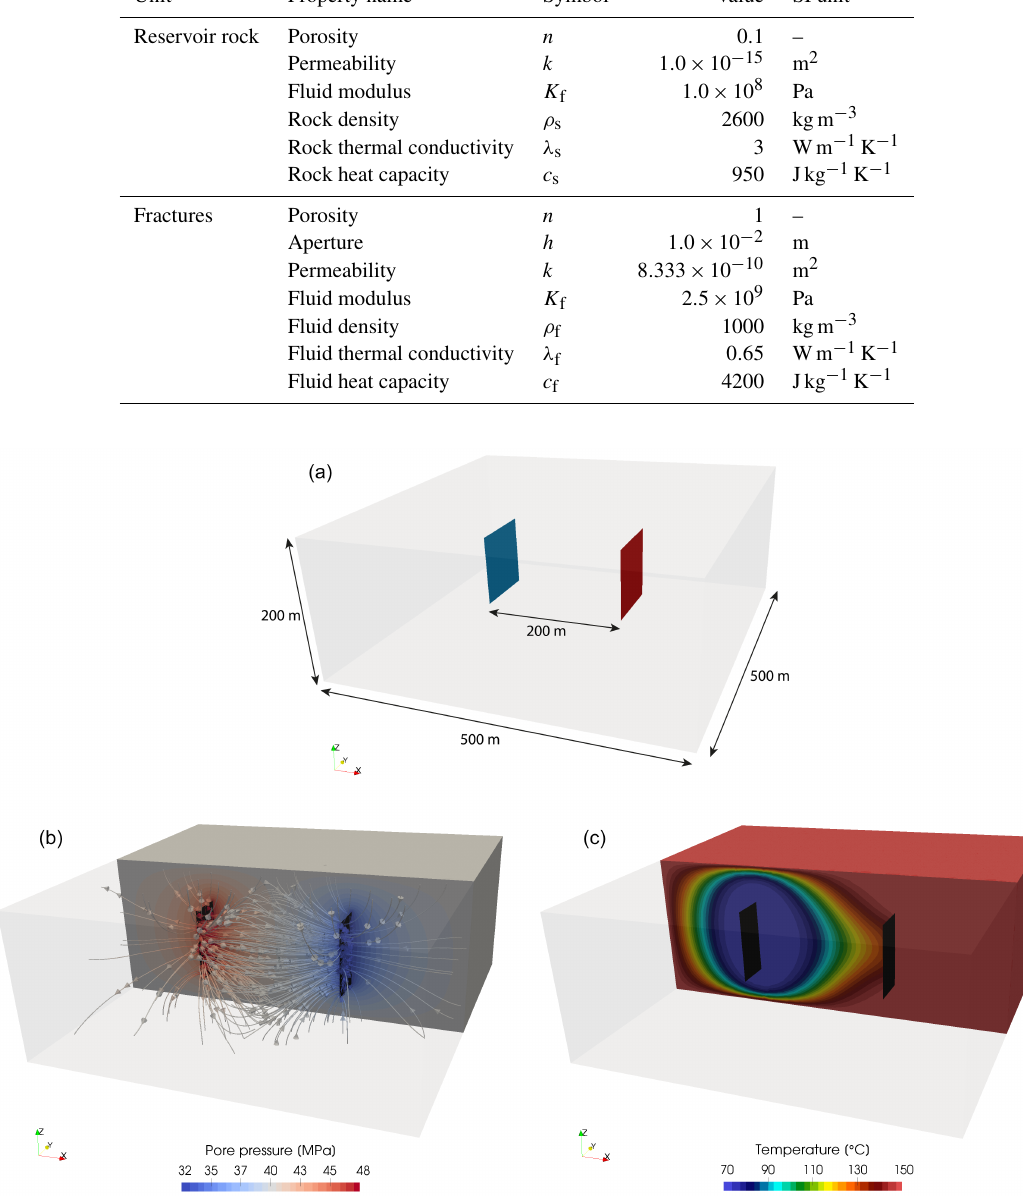
Figure 10. Problem formulation and results of the thermo-poroelastic response of a geothermal doublet. Panel (a) shows the problem formulation. Panels (b) and (c) illustrates the pore pressure (with fluid velocity) and temperature distributions respectively after 50 years of